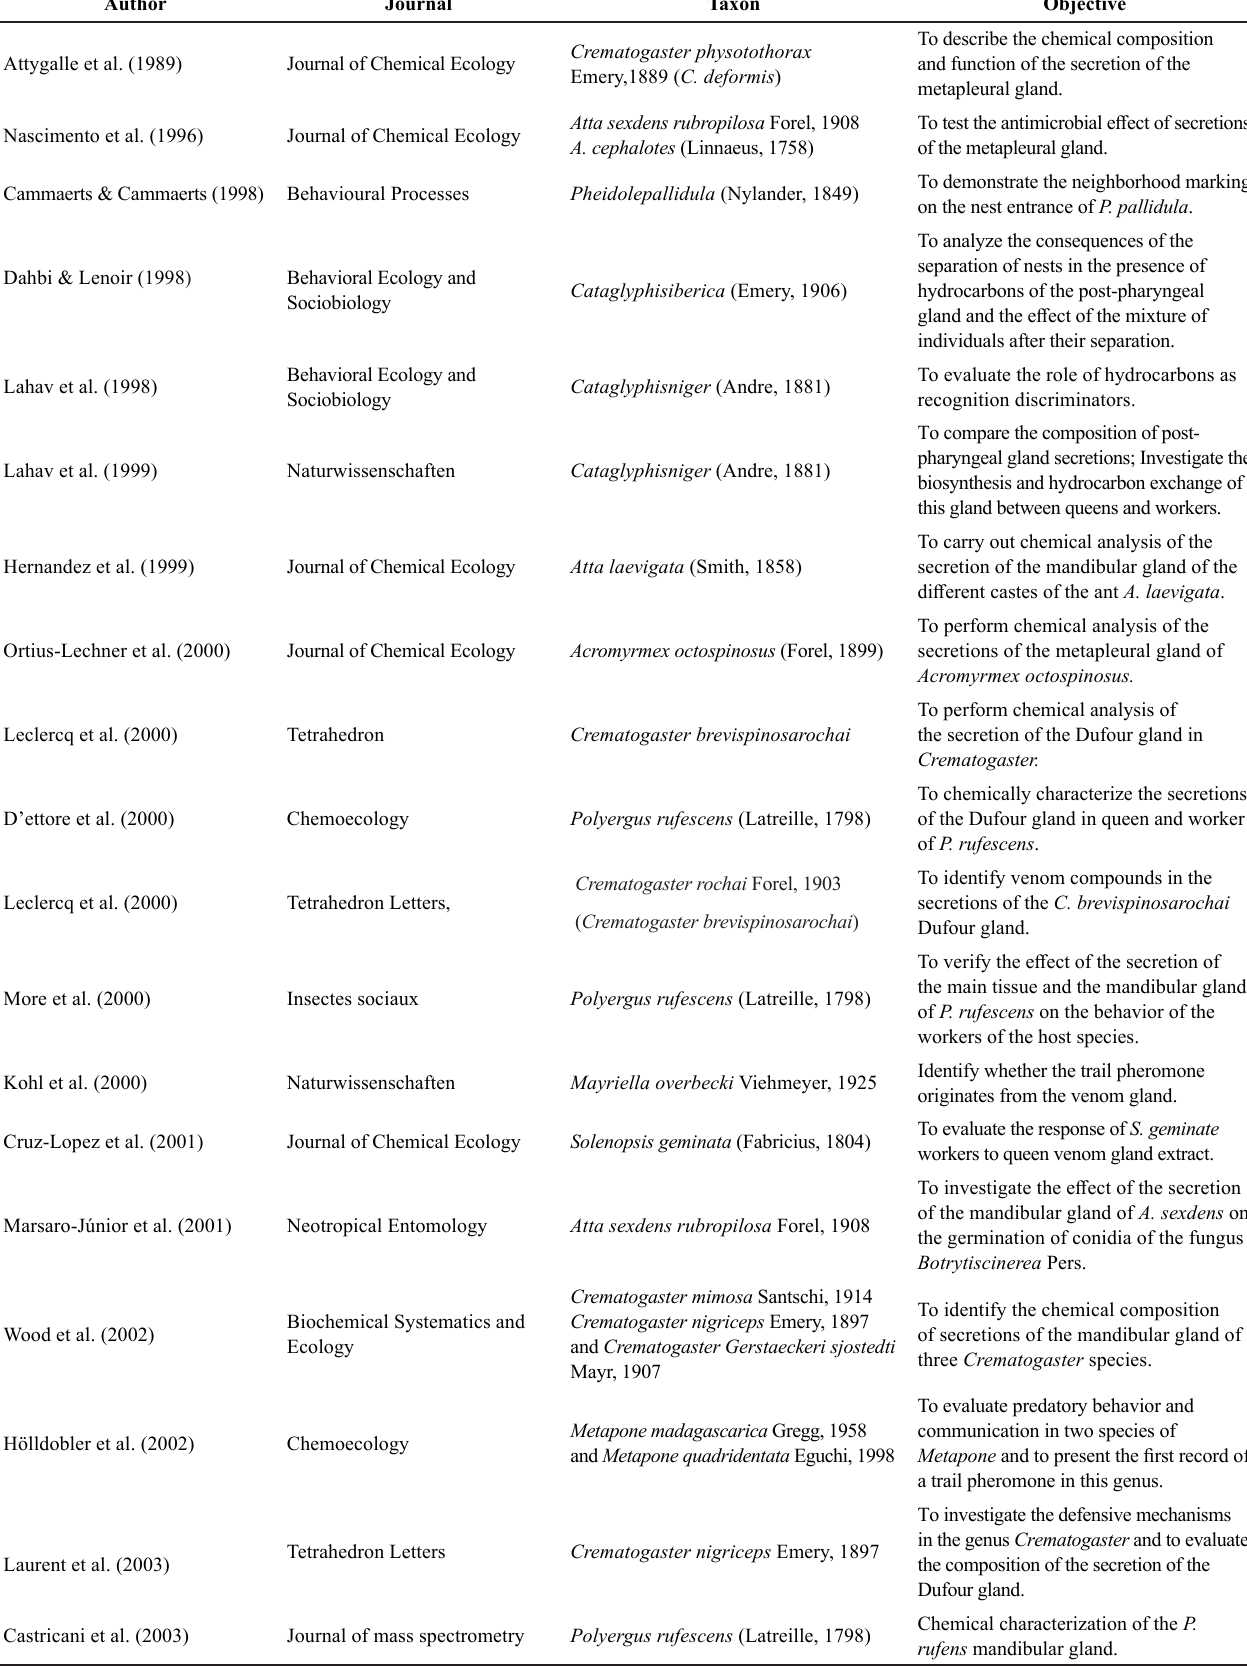
Table 1 . Authors, publication period, ant taxon used and objective of articles involving extraction of ant secretions in the period between 1989 and